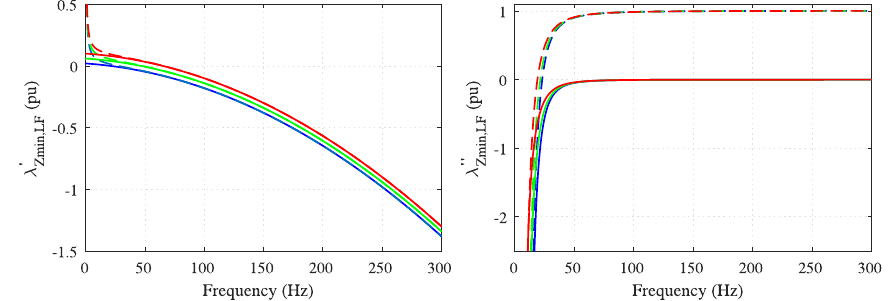
Figure 11. Frequency characteristic of λ (cid:48) R v = 0.02 pu (blue), R v = 0.06 pu (green), and R v = 0.10 pu (red); solid curves represent the case of considering only the virtual-impedance dependent term (exp-1) from Z (cid:48)